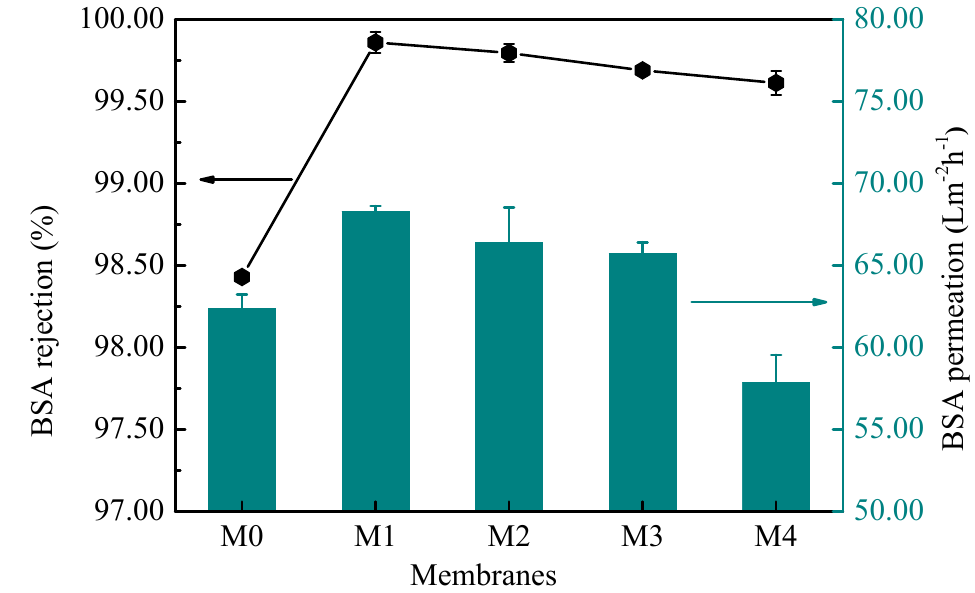
Figure 9. BSA rejection of TUF membranes with different concentrations of MoS 2 . using HA aqueous solution as the feed solution. This result shows in Figure 10,